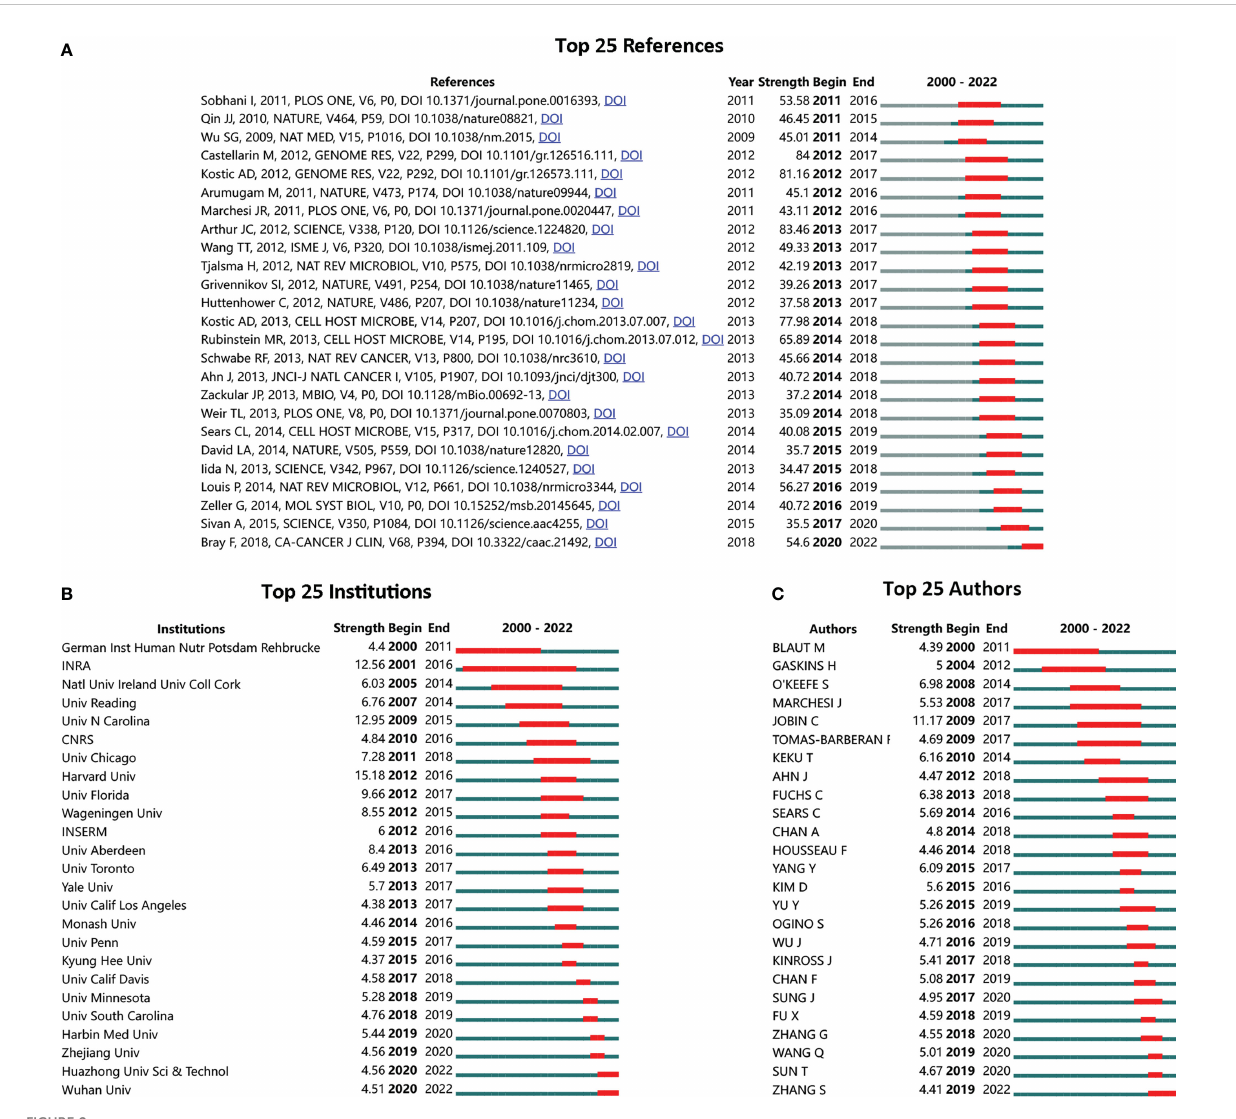
FIGURE 2 Top-listed references, institutions, and authors with the strongest citation bursts (SCB). (A) Top 25 SCB references; (B) top 25 SCB institutions; (C) top 25 SCB authors; red bar to green bar indicates high frequent occurrence of citation period compared to common frequent citation